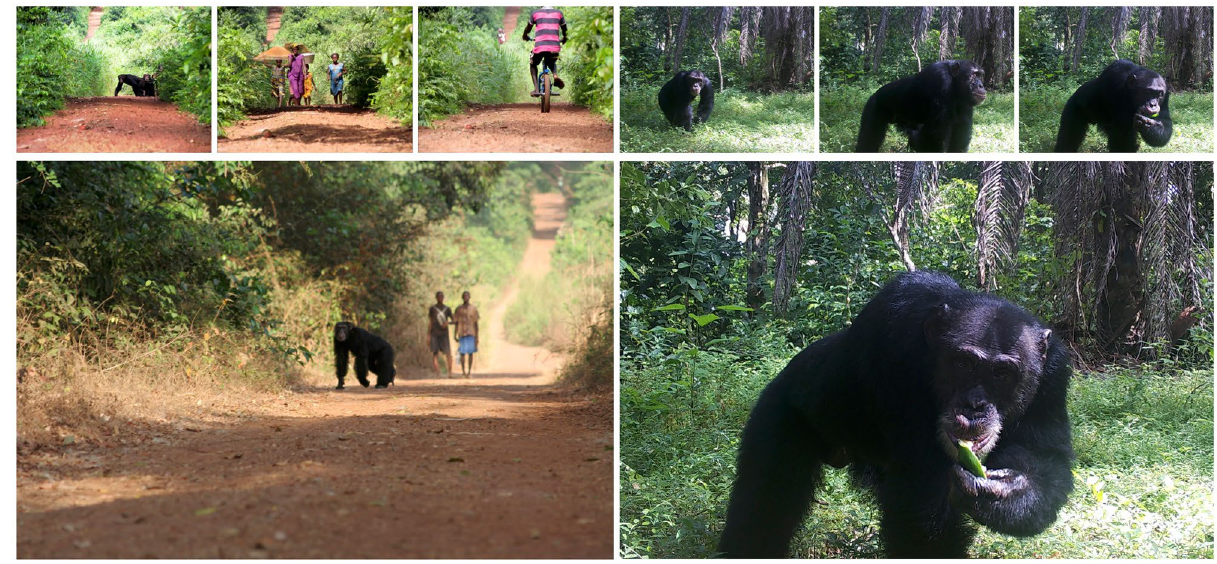
Figure 5. Chimpanzees in Caiquene–Cadique often use the roads located at the centre of their home range and frequently feed on cultivated foods. The camera trap images (right) show a chimpanzee entering Caiquene village to feed on orange in October